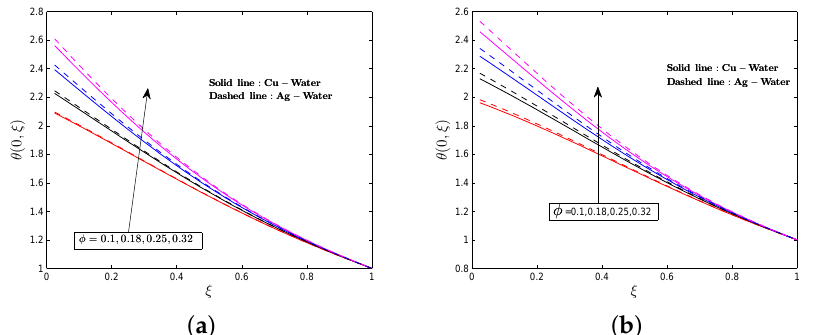
Figure 21. Surface temperature for various values of φ . ( a ) vertical plate; ( b ) horizontal plate.